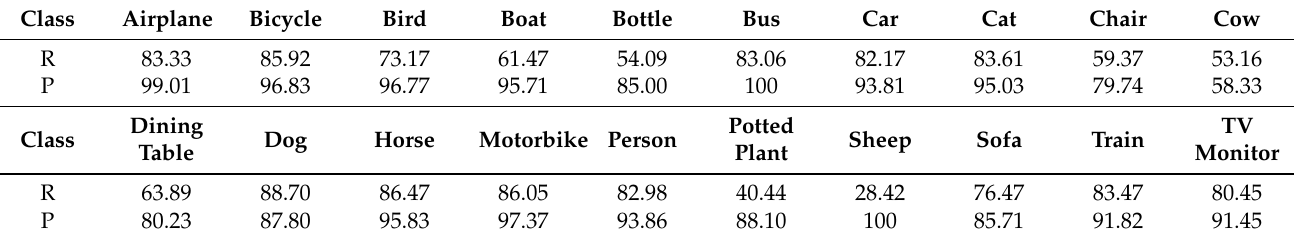
Table 4. The R and P values for all classes.